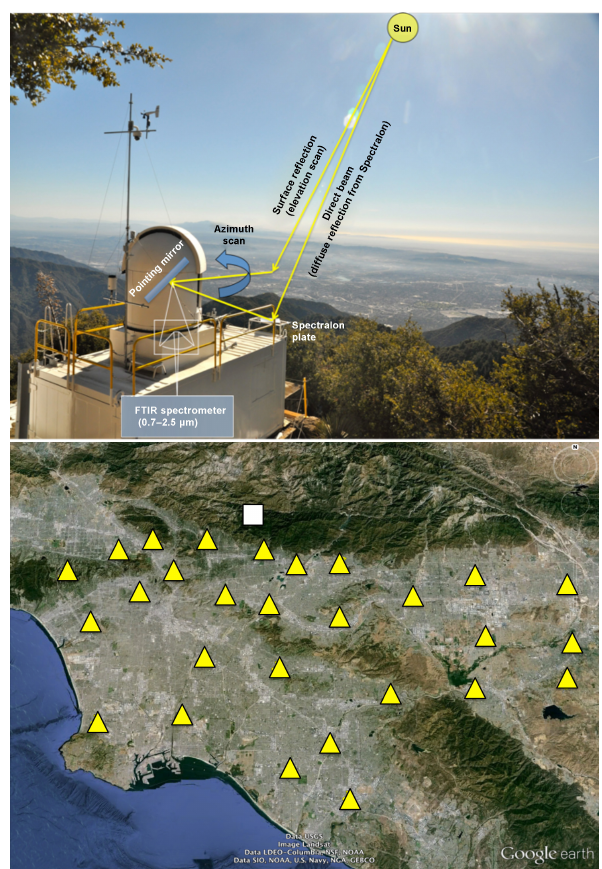
Figure 1. Top: CLARS facility located at 1.67km above sea level on Mount Wilson, looking over the Los Angeles Basin. Optical paths from direct sun beam and basin surface reflection are shown as yel- low lines. Bottom: location of 29 reflection points on Mount Wilson (white square) and in the basin (yellow